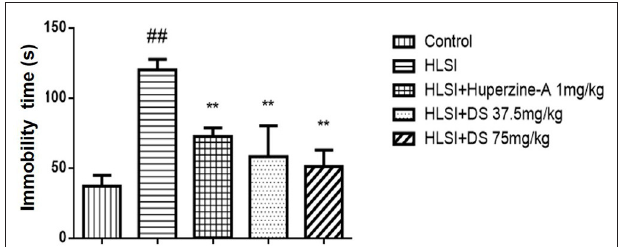
FIGURE 6 | The effects of DS on the number of rearings in the open-field test after HLSI in rats. The values are mean ± SEM ( n = 7). The symbols represent: ## p < 0.01 as compared with the control group; * p < 0.05 and ** p < 0.01 as compared with the HLSI group.